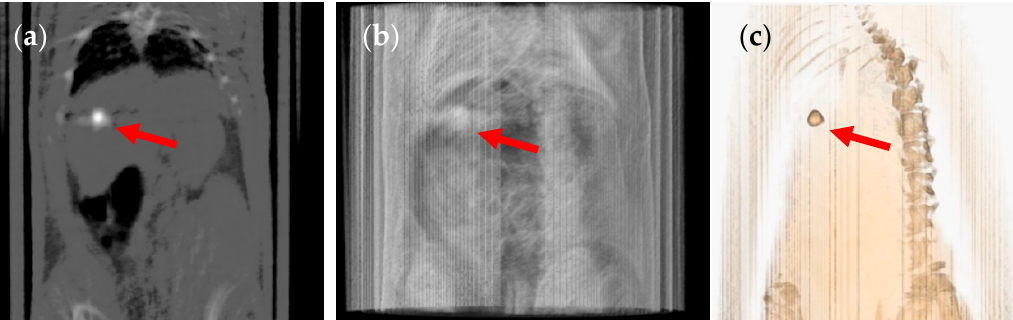
Figure 5. ( a ) Coronal CT slice of the size 9 capsule in the stomach of the rat, ( b ) planar CT projection and ( c ) three-dimensional rendered CT image of the same animal. The capsule is indicated by a red arrow. Image taken without anaesthesia.